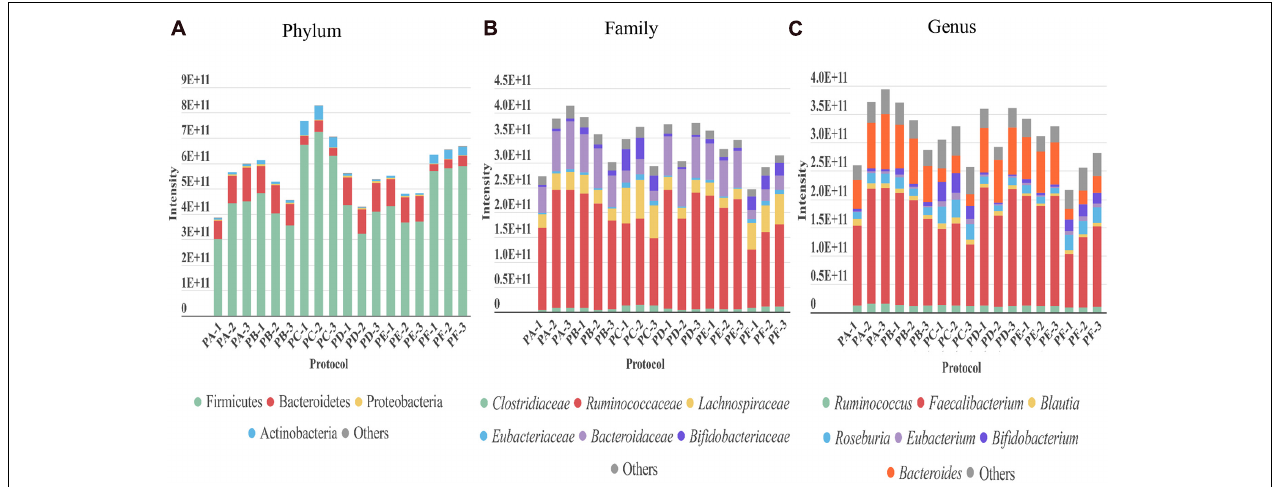
FIGURE 3 | Taxonomic distribution revealed by each of the three replicates performed with every protocol (PA–PF) from stool sample H1. The intensity of each taxon in the different taxonomic levels (A) phylum, (B) family, and (C) genus (directly related to its abundance) is represented as the sum of the intensities of all the distinctive peptides assigned to that